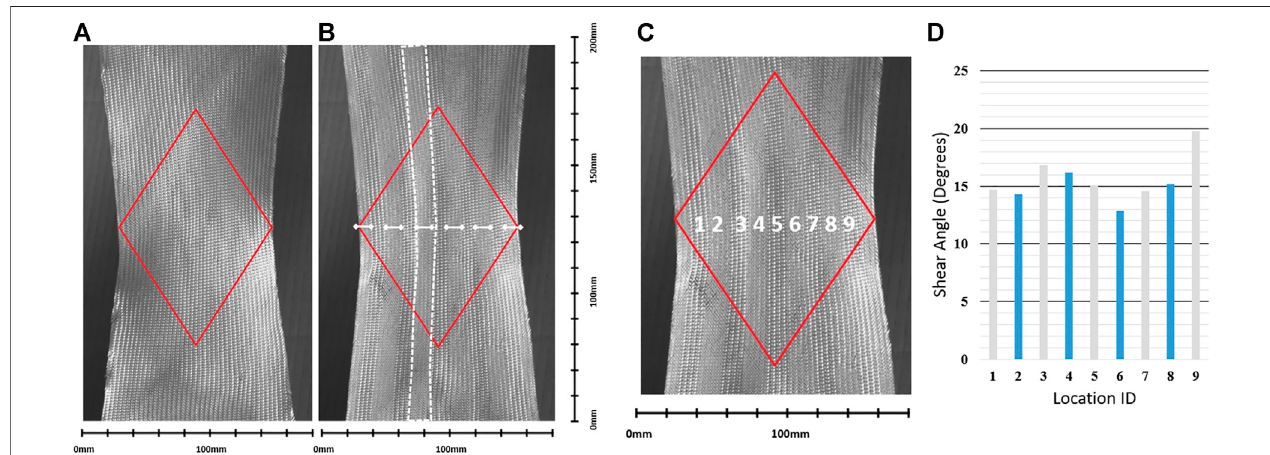
FIGURE 11 | (A) Image taken by videogauge at 0% coverage (B) image taken by videogauge at 50% coverage. (C) labels of shear angle measurement locations reading horizontally across the sample (D) charts the shear angle with grey denoting dry fabric and blue denoting patched locations. The red diamond outlines the approximate edges of the theoretical pure shear zone. The patch locations are indicated in white with one patch